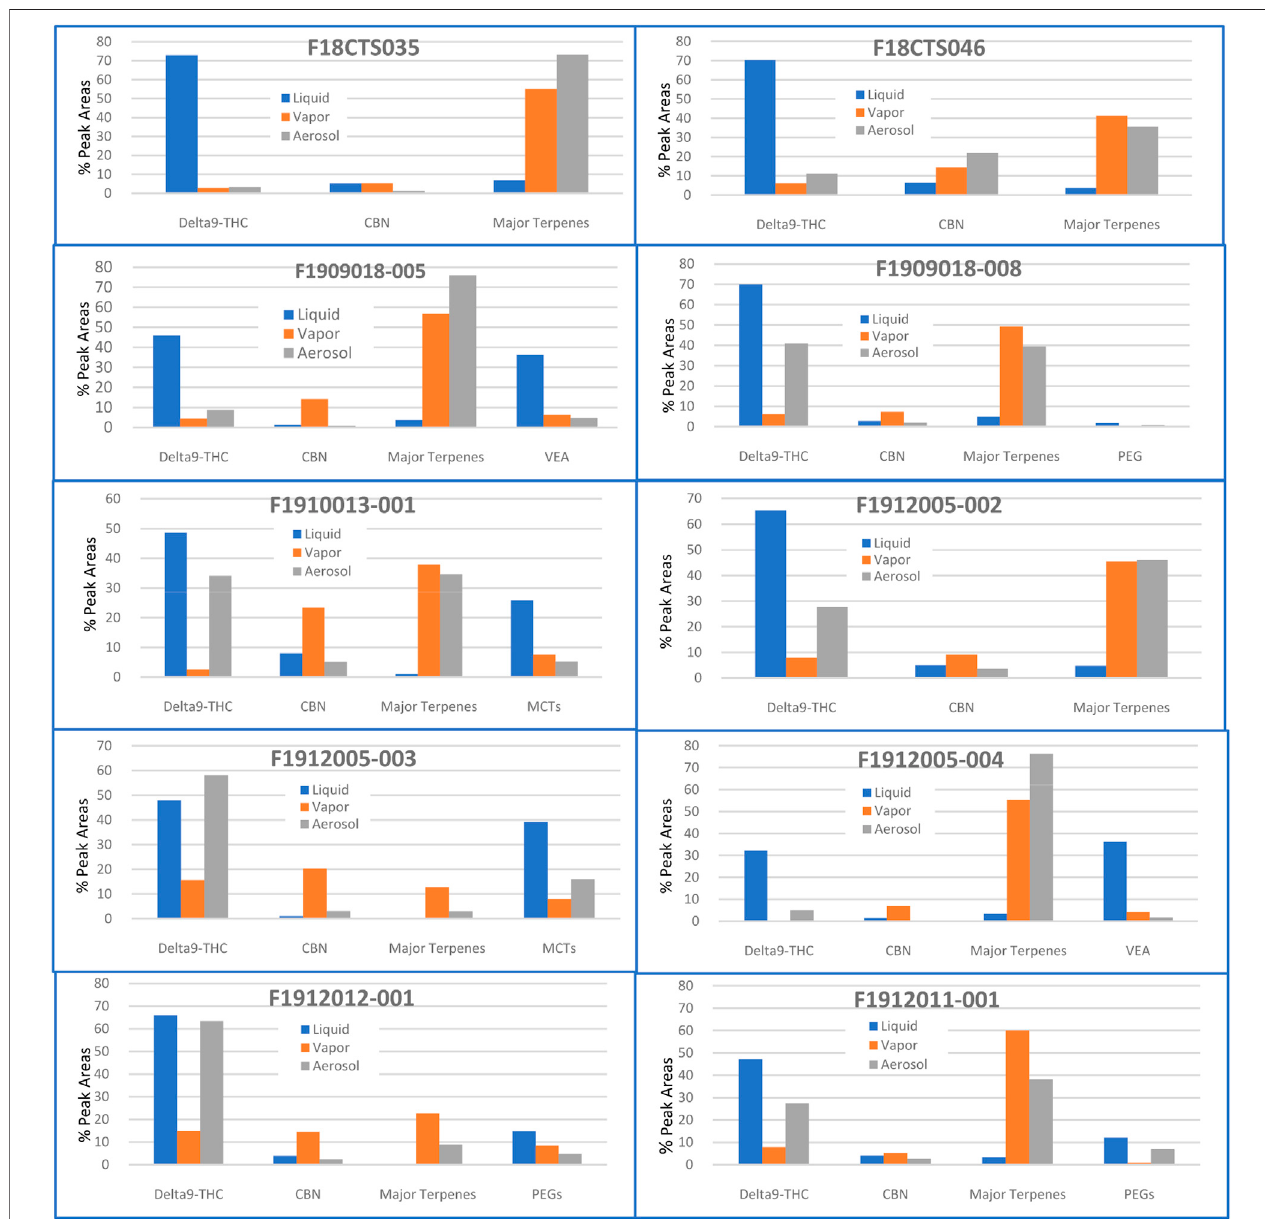
FIGURE1| Majorterpenes, Delta9-THC,and majoradditives invape oilliquid,vaporandaerosolofeach vapeoil cartridgesample.%PeakArea,areapercentage of each peak or compound found in instrument analysis. It roughly represents the composition or amounts present in the sample.